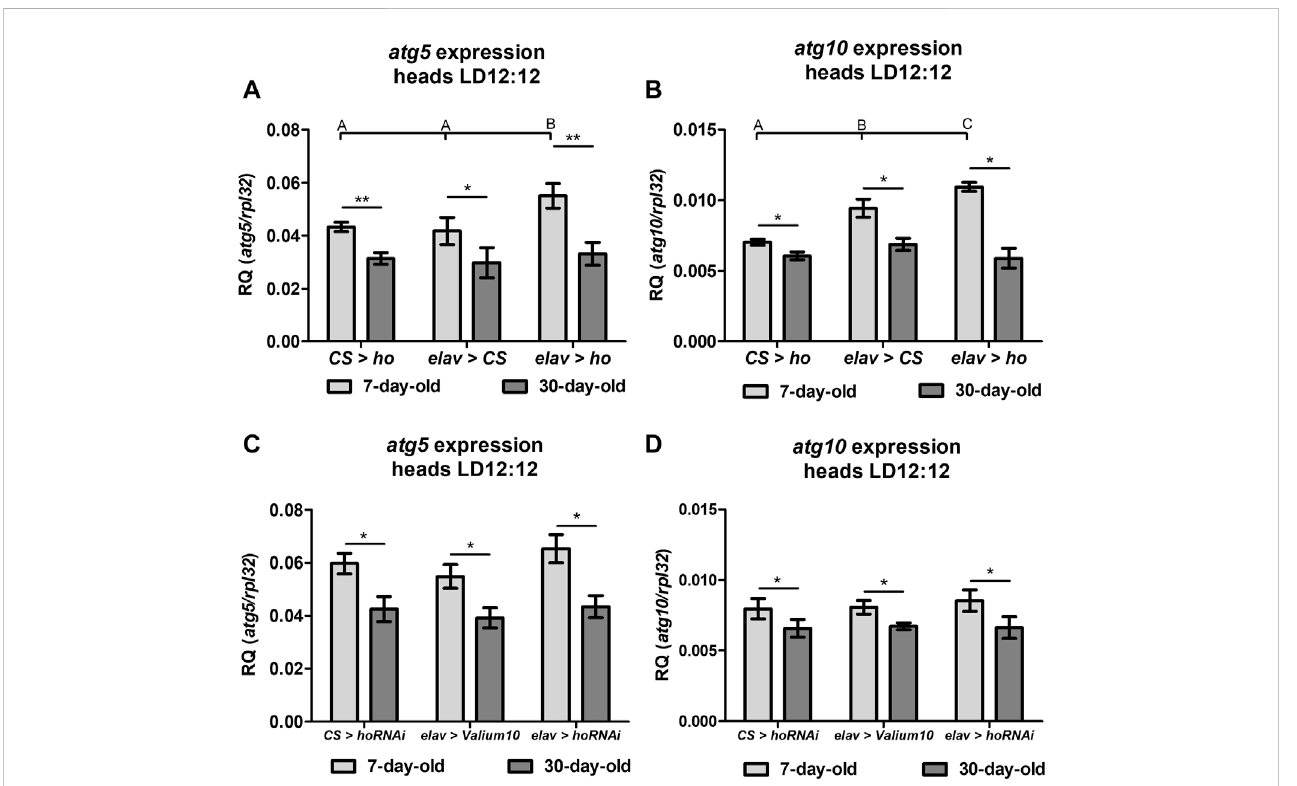
FIGURE 3 Expression of the autophagy-related genes ( atg5 and atg10 )was induced in heads of fl ies with pan-neuronal ho overexpression ( (A) – atg5 , (B) atg10 )but not with pan-neuronal ho silencing ( (C) – atg5 , (D) atg10 ) and was independent on age (means ± SD). Statistically signi fi cant differences between genotypes are indicated with different letters (non-parametric ANOVA Kruskal – Wallis and post hoc Conover-Iman tests: atg5 in fl ies with ho overexpression and 7-day- old p = 0.02,30-day-old p =0.6; atg10 in fl ieswith ho overexpression in7-day-old p =0.003, 30-day-old p =0.05; atg5 in ho silencing in7-day-old p = 0.1, 30-day-old p = 0.2; atg10 in ho silencing in 7-day-old p = 0.5, 30-day-old p = 0.9) and between different age groups by asterisks (7-day-old vs. 30-day- old in each genotype; non-parametric Mann-Whitney test - atg5 : elav > ho p = 0.01; CS > ho p = 0.008; elav > CS p = 0.03; elav > hoRNAi p = 0.03; CS > hoRNAi p = 0.02; elav > Valium10 p = 0.004; atg10 : elav > ho p = 0.02; CS > ho p = 0.03; elav > CS p = 0.03; elav > hoRNAi p = 0.03; CS > hoRNAi p = 0.03; elav > Valium10 p = 0.02). These experiments were repeated at least three times per genotype or age group with 20 heads per